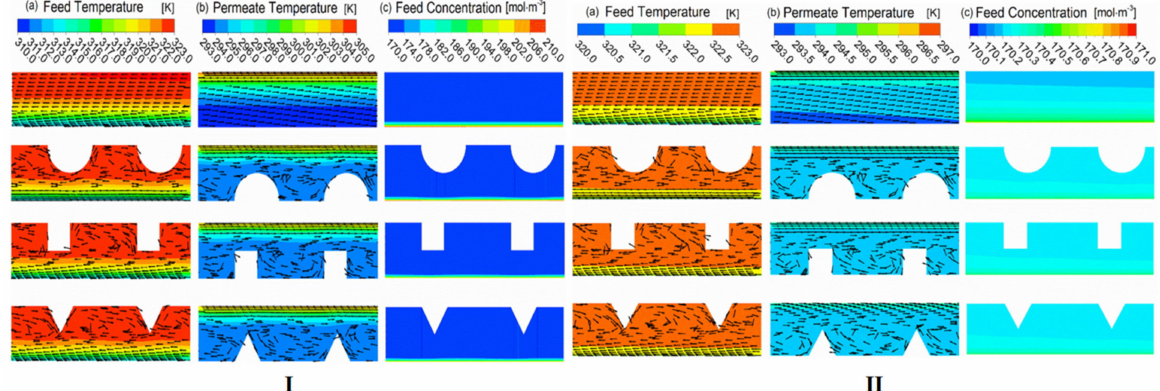
Figure 13. Local flow field visualization for various baffled modules [30]. Reproduced with permission from Elsevier, 2019. ( I ) under the laminar flow at 0.05 m/s (Re Feed = 358; Re Permeate = 200); ( II ) under the turbulent flow at 0.55 m/s (Re Feed = 3935; Re Permeate = 2196).